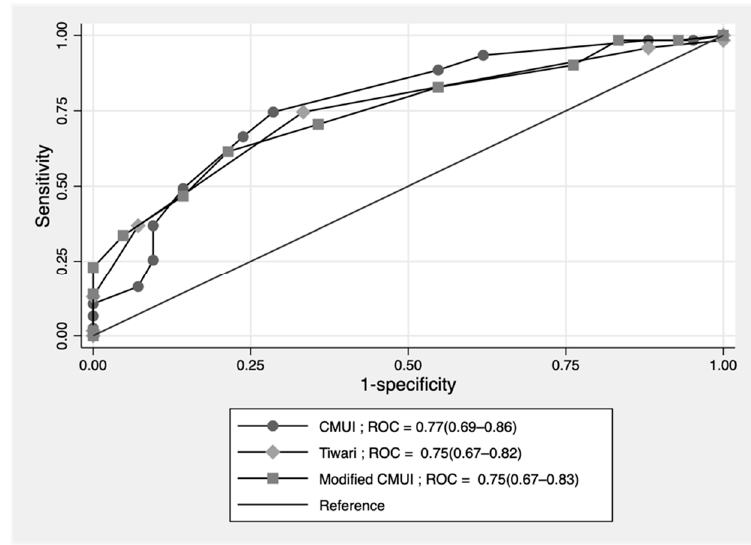
Figure 7. Comparative ROC curve of failure of nonoperative reduction of intussusceptions among 3 score models.